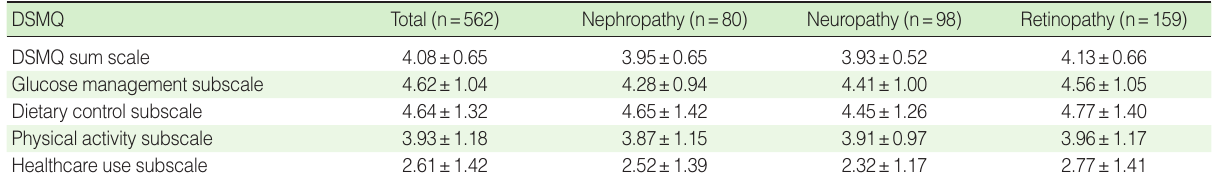
Table 2. The Diabetes Self-Management Questionnaire (DSMQ) self-care activities scores, overall and subcategorized according to the presence of the microvascular complications of diabetes DSMQ Total (n=562)